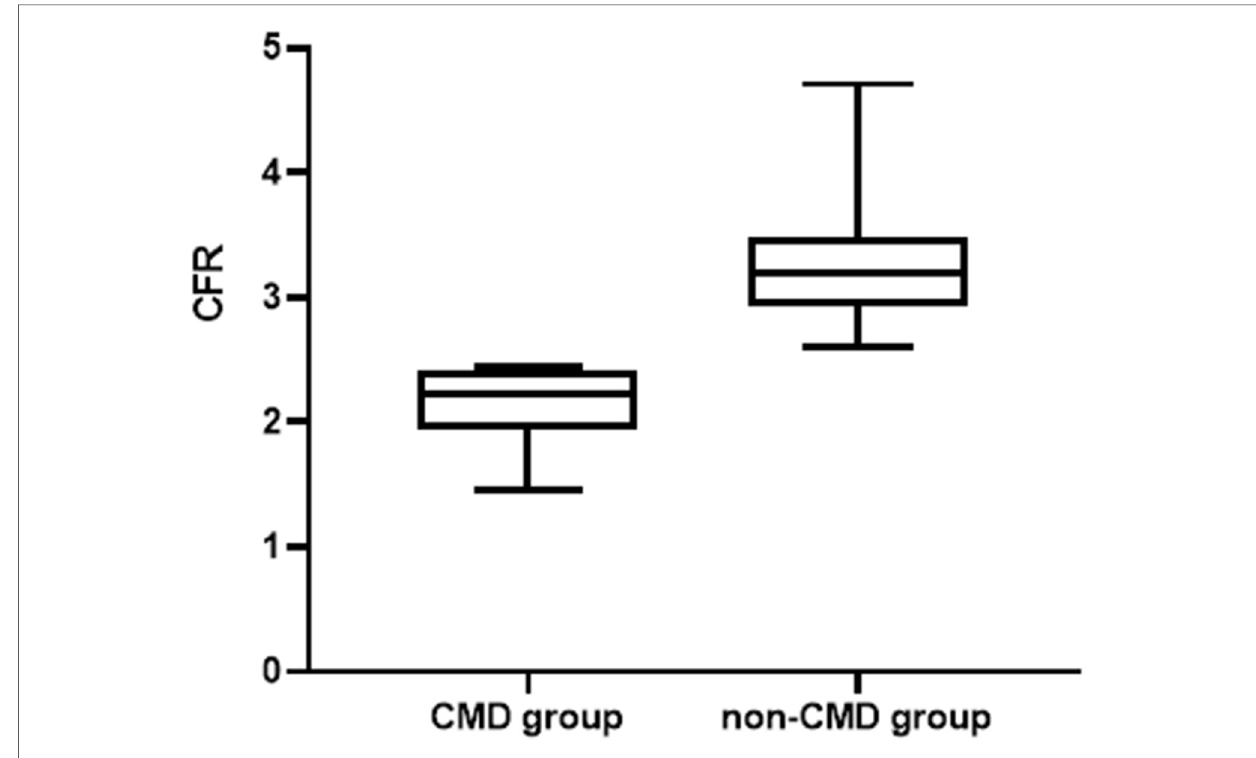
FIGURE 1 Comparison of CFR between the two groups. CFR, coronary fl ow reserve; CMD, coronary microvascular